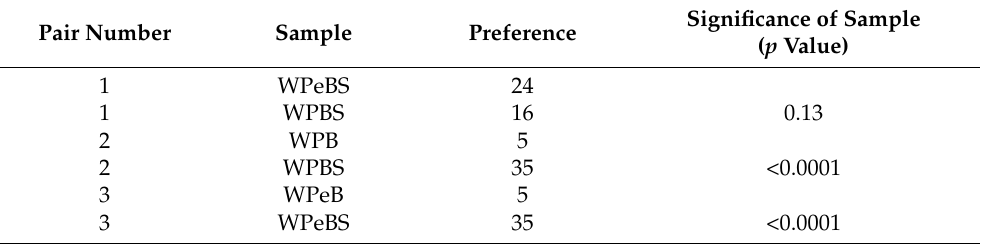
Table 5. Volunteers’ counts of whey beverage preference (WPeB: whey permeate beverage; WPeBS: